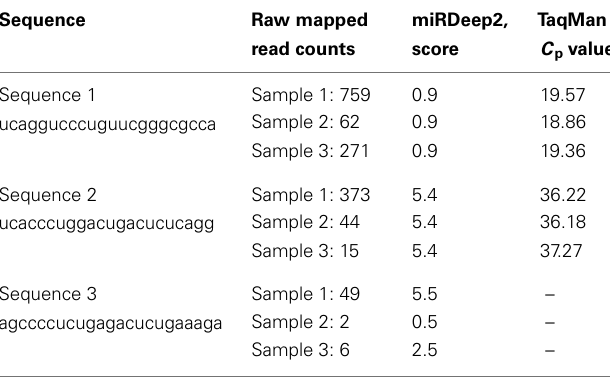
Table 1 | qRT-PCR results for three potential novel miRNA sequences predicted by